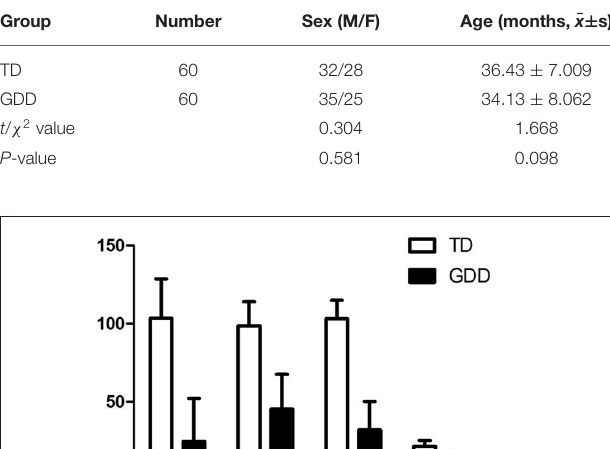
receiver operating characteristic (ROC) analysis. The area under the ROC curve was used as a diagnostic performance indicator to distinguish children with GDD from those that were TD.